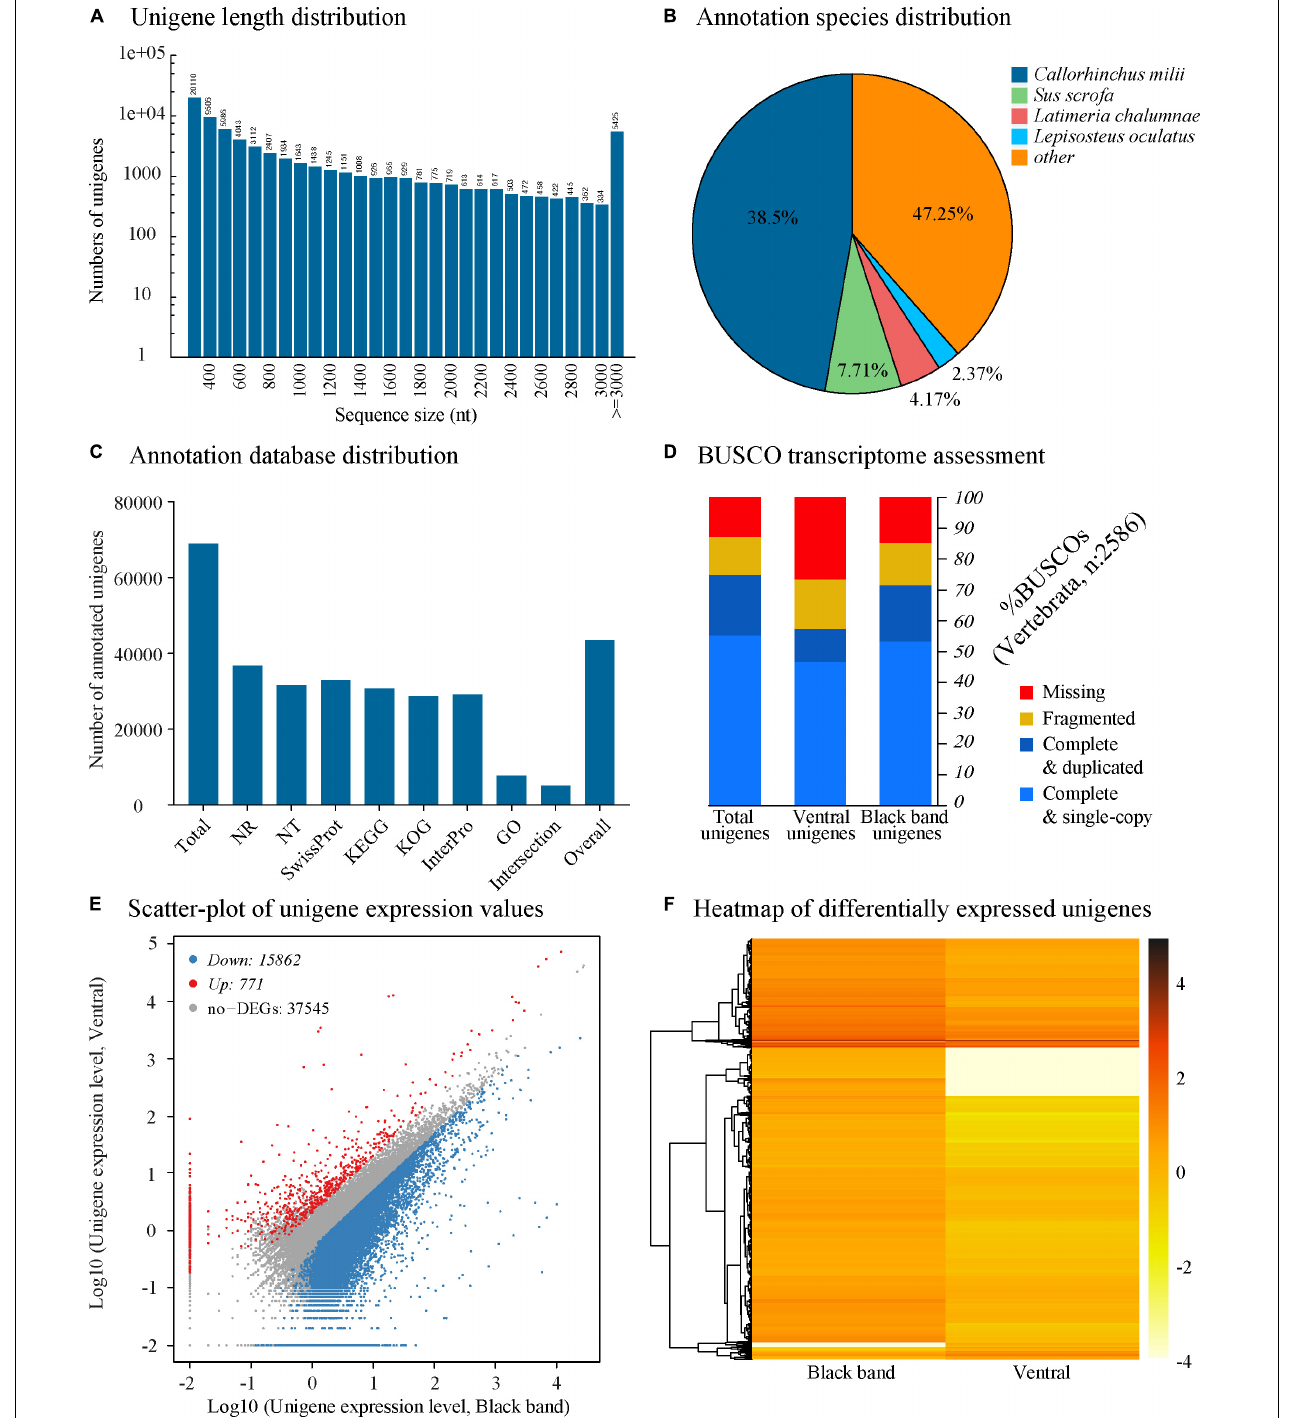
FIGURE 2 | Isistius brasiliensis transcriptome summary. (A) Unigenes length distribution of the global transcriptome, (B) species distribution of the top BLAST hits for all unigenes, (C) annotation summary for all investigated databases: NR, KOG, KEGG, Swissprot and Interpro. The category “intersection” refers to unigenes that are commonly annotated in all databases. In contrast, the category “overall” refers to unigenes that are uniquely annotated in one of the tested databases (D) BUSCO transcriptome assessment, (E) comparative unigenes expression between the black band and the ventral integument transcriptomes, (F) heatmap of log 2 (FoldChange) of differentially expressed unigenes based on the Poisson distribution (corrected P -value FDR ≤ 0.001, | log 2 (FoldChange)| ≥ 1) (Audic and Claverie, 1997).